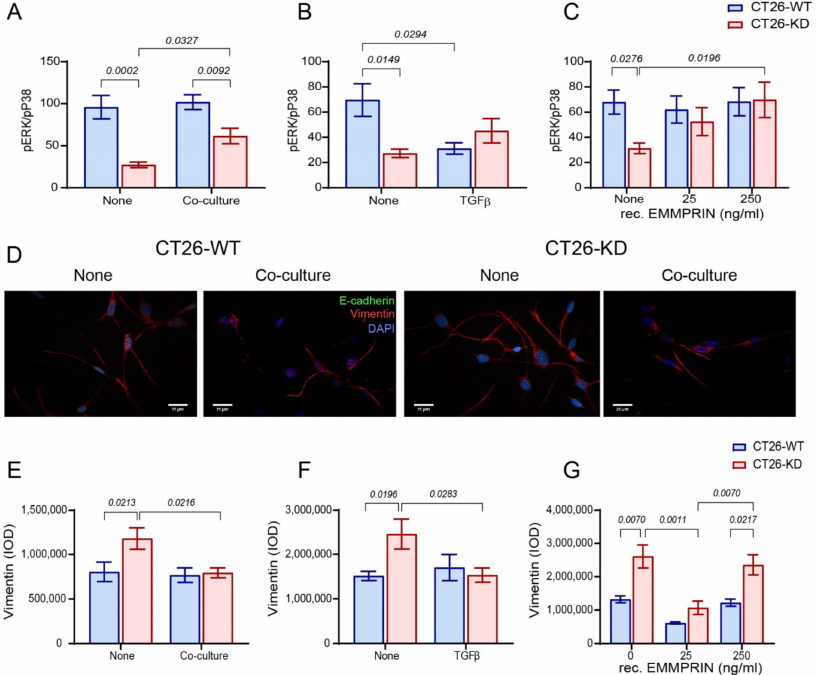
Figure 3. CT26-KD cells exhibit reduced levels of ERK activation and enhanced expression of vimentin, which are reversed by the co-culture or its simulation. CT26-WT or CT26-KD cells (1.5 × 10 5 cells) were each cultured alone or in co-culture with RAW 264.7 cells that were seeded in the upper chamber of the inserts at a ratio of 1:1, in serum-starvation medium (final volume 650 µ L) for 48 h. Alternatively, single cultures of CT26-WT or CT26-KD cells (1.5 × 10 5 cells/650 µ L) were cultured with or without the addition of recombinant TGF β (10 ng/mL) or recombinant EMMPRIN (25 ng/mL or 250 ng/mL). Lysates were extracted from the CT26 cells in lysis buffer in the presence of proteinase inhibitors, and the concentrations of phosphorylated ERK1/2 and p38 were determined by ELISA. The ratio pERK/pP38 was calculated for ( A ) the co-culture ( n = 5), ( B ) the addition of TGF β ( n = 5), and ( C ) the addition of recombinant EMMPRIN ( n = 6). ( D – G ) CT26-WT and CT26-KD cells (3 × 10 4 cells each) were incubated as in ( A – C ), mounted on cover slips, and stained for the expression of the proteins E-cadherin (green) and vimentin (red), and using DAPI (blue) to stain cell nuclei. Bar size is 25 µ M. ( D ) Representative images of the staining in co-culture, quantification of vimentin expression ( E ) in the co-cultures ( n = 6), ( F ) with addition of TGF β ( n = 5), and ( G ) with addition of recombinant EMMPRIN ( n = 4). Data are presented as means ± SE, and analyzed using a two-way ANOVA followed by Bonferroni’s post-hoc